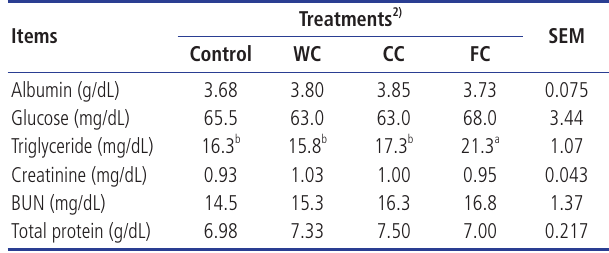
Table 4. Effect of feeding Korean domestic corn grain by different particle size on blood metabolites of Holstein steers fed total mixed ration as a basal 1)